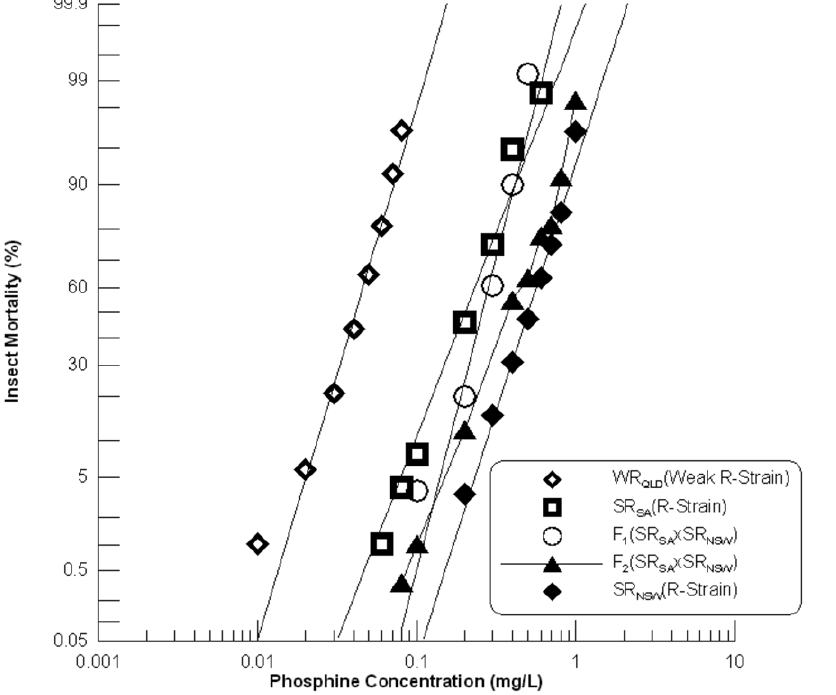
Figure 2. Resistance response of F 1 hybrids and F 2 progeny of a cross between strongly resistant R.dominica strains from South Australia and New South Wales. Results are presented as log-dose mortality of the F 1 hybrids and the F 2 progeny, together with reference curves of the parental strains, SR SA and SR NSW , and the weakly resistant strain from Queensland (WR QLD ). Phosphine exposure was for 48 hours at 25 u C and 70% r.h.